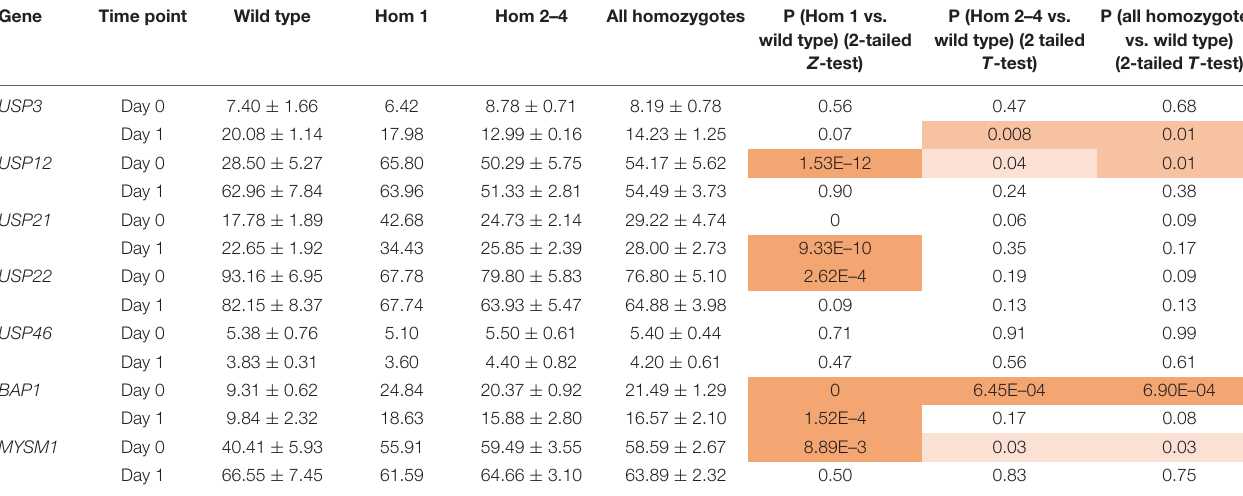
TABLE 2 | Expression of deubiquitinases in USP16 edited cells.